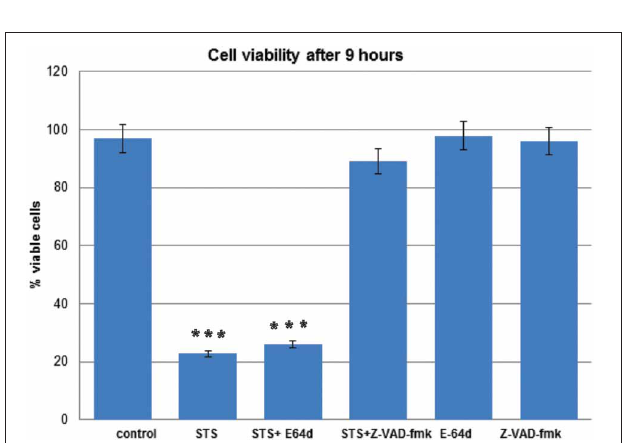
FIGURE 1 | Representative images of T98G cells after 5h of incubation with 500nM STS. Following treatment with 500nM STS cells shrunk, rounded, and detached from the surface as seen by light microscopy (A) untreated cells (B) cells treated with 500nM STS. The majority of these morphological changes were prevented by Z-VAD-fmk (C) , but not by E-64d (D) . Bar 200 μ M.